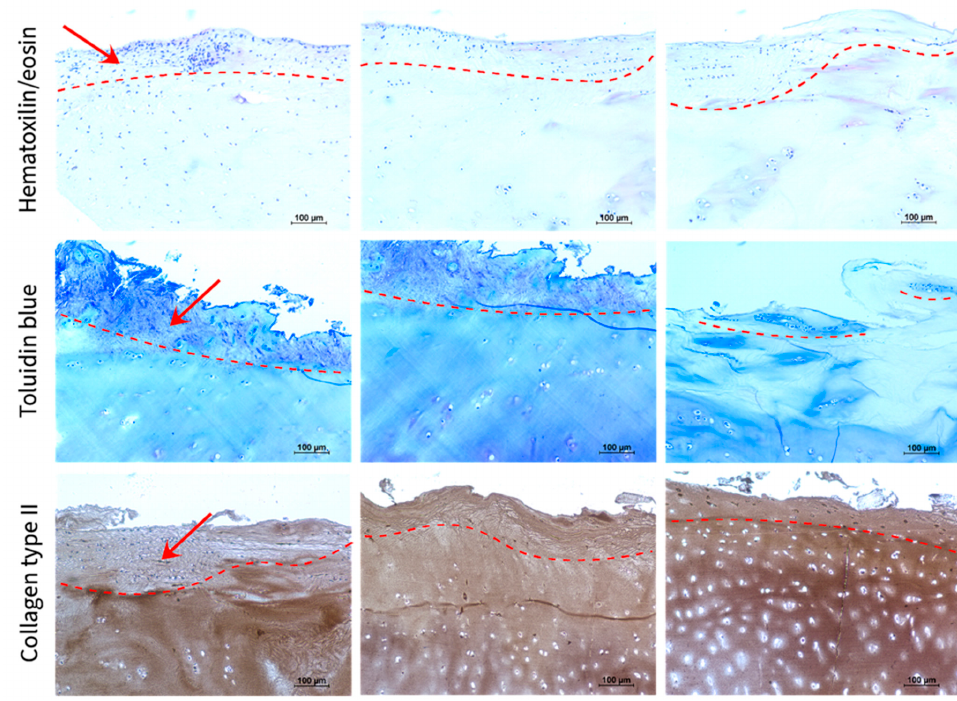
Figure 6. Histochemical and immunohistochemical analysis of OA cartilage explants coated with CS-Tyr/Gel/BM-MSC hydrogel, cultured in DMEM medium, chondrogenic medium and chondrogenic medium with TGF- β 3 for 21 days. Cells in the CS-Tyr/Gel and cartilage tissue were identified by hematoxylin/eosin staining (cell nucleus are dark blue, other structures-pink). Toluidine blue identifies proteoglycans (blue), and collagen type II was identified immunohistochemically (brown). Red arrows show the added CS-Tyr/Gel/BM-MSCs, while the dash line shows an approximate boundary of added CS-Tyr/Gel/BM-MSCs composite after 21 days of incubation.